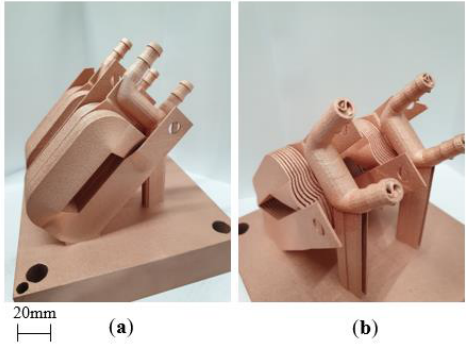
Figure 14. Examples of pure Cu coil winding and incorporated Triply Periodic Minimal Surface heat exchanger samples, where ( a ) displays the coil winding structure and ( b ) displays heat exchanger with internal TPMS structures.